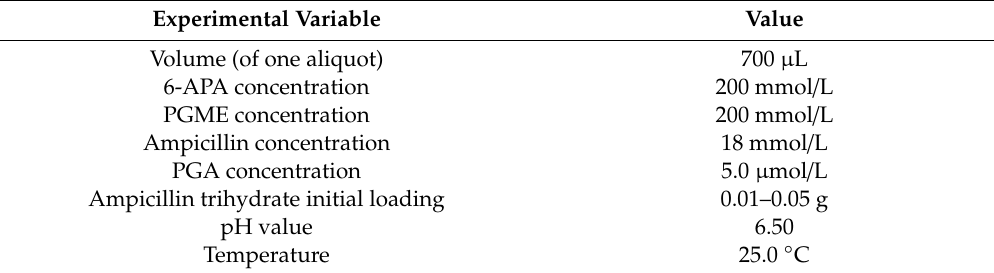
Table 1. Initial conditions for growth